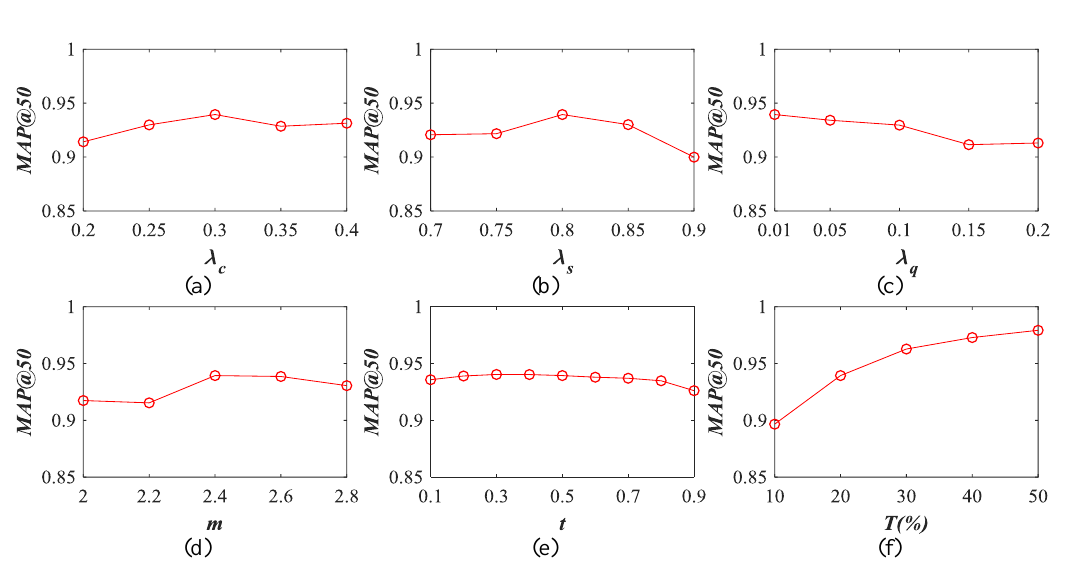
Figure 21. Influence of different parameters on our hash learning model. The results are counted on the AID dataset using the 128 bits hash codes: ( a ) λ c ; ( b ) λ s ; ( c ) λ q ; ( d ) m ; ( e ) t ; and ( f ) T